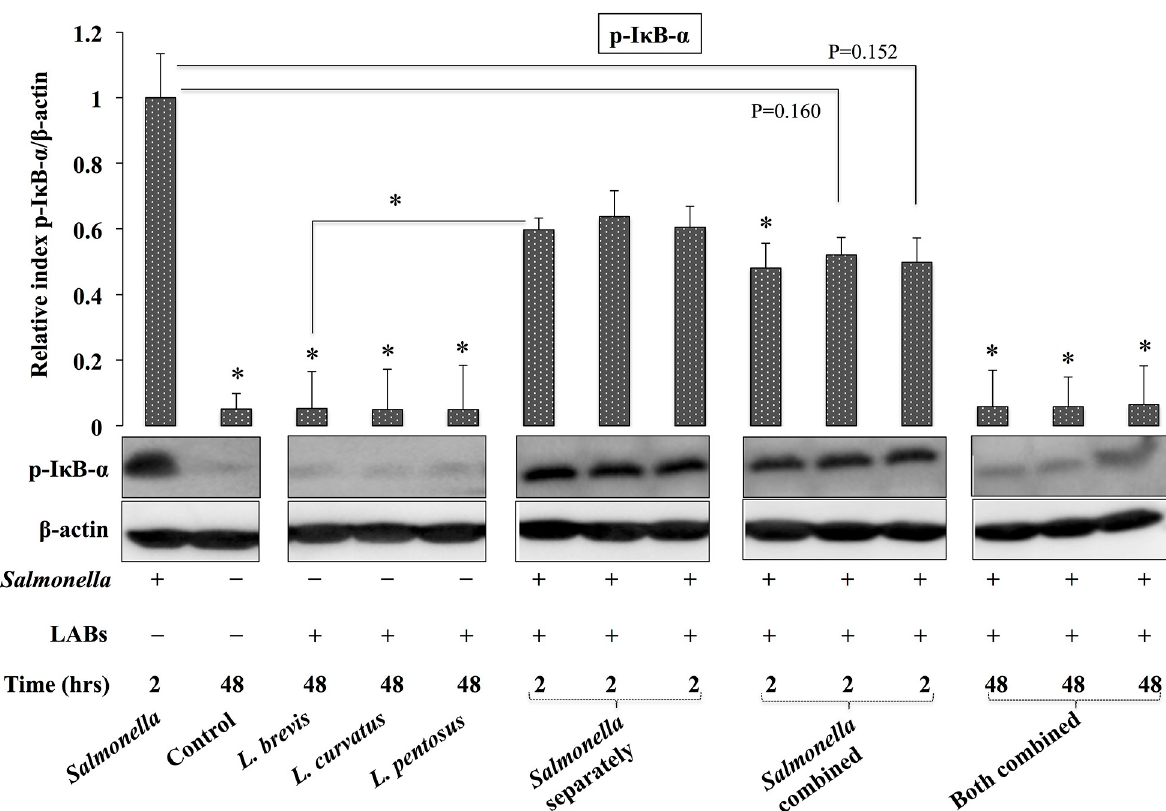
Fig 7. LABs inhibited Salmonella induced NF- κ B activation in vitro . HT-29 cells were stimulated as follows: Salmonella alone, medium alone (control), LABs alone, LABs + Salmonella (2 h separately), LABs + Salmonella (2 h combined), and LABs + Salmonella (48 h). The protein level of p- I κ B- α was analyzed by western blot. The image J software used to determine intensities of proteins bands. Significant differences between the groups, � p < 0.05.